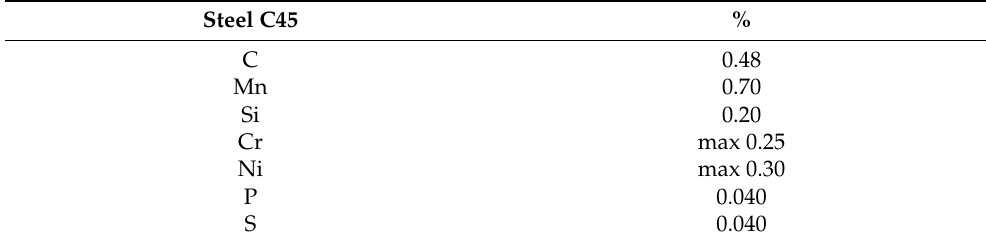
Table 2. Chemical composition of steel C45 [41].